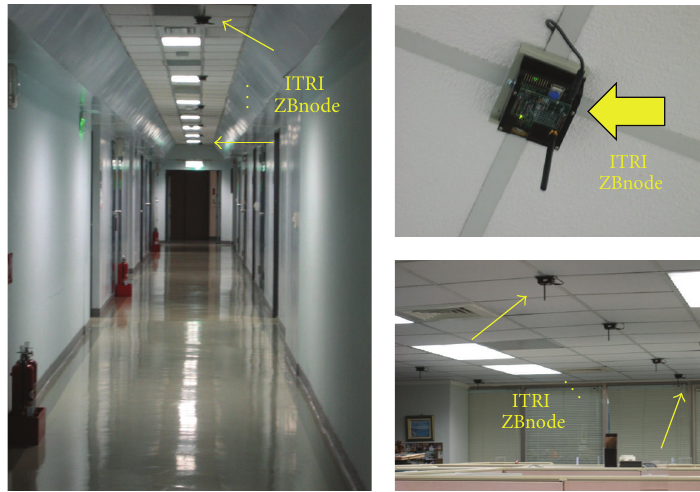
Figure 7: Sensor nodes attached to the ceiling of the hallway and room.